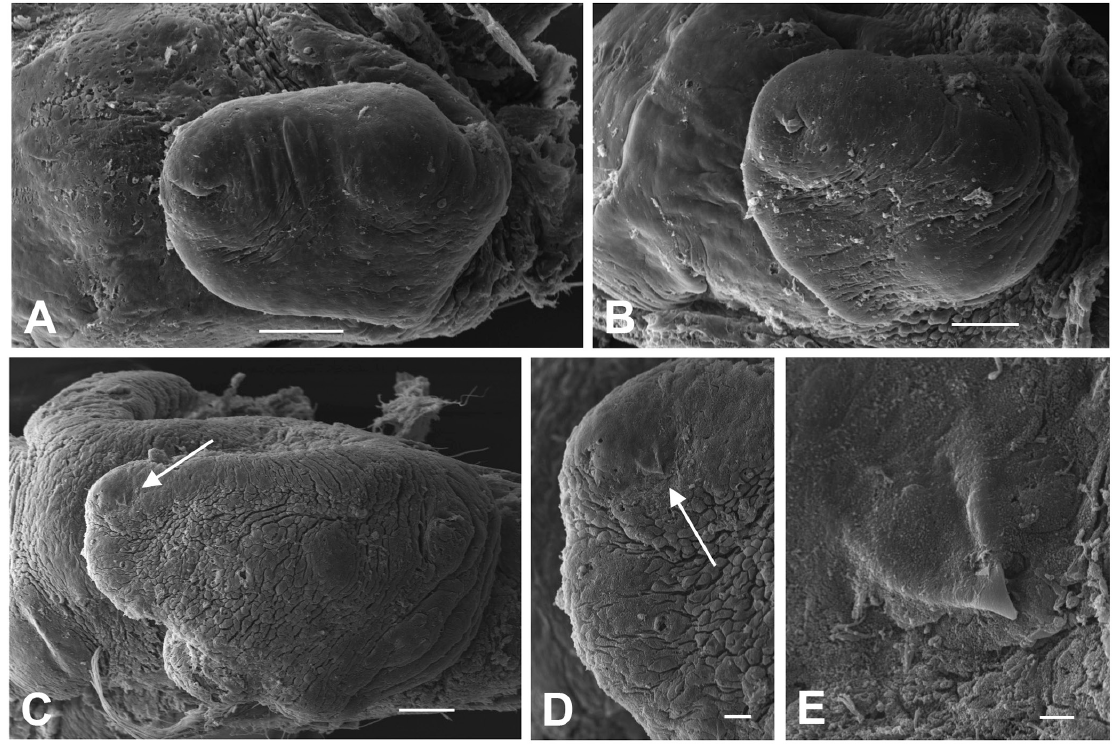
Fig. 17. Penes (SEM micrographs). A–B . H. lozekiana sp. nov. (different specimens). C–E . H. steffeki sp. nov. (one specimen). Arrow points at penial stylet, which is withdrawn in A and B. Scale bars: A–C = 50 µm; D = 10 µm; E = 2